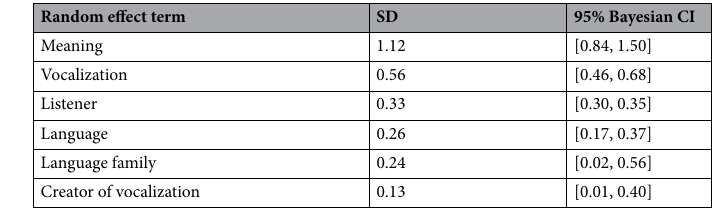
Table 1. Random effects standard deviations from the Bayesian logistic regression model for the web data; ordered from highest to lowest standard deviation; larger SDs indicate that accuracy levels varied more for that random effect